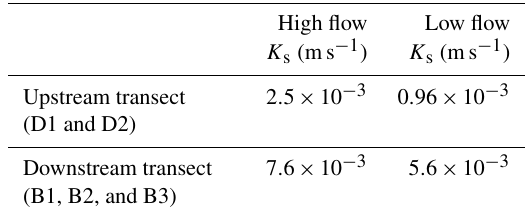
Table 1. Estimated saturated hydraulic conductivity of the outwash plain for high-flow and low-flow conditions during the summer period along two transects based on the pressure wave diffusion